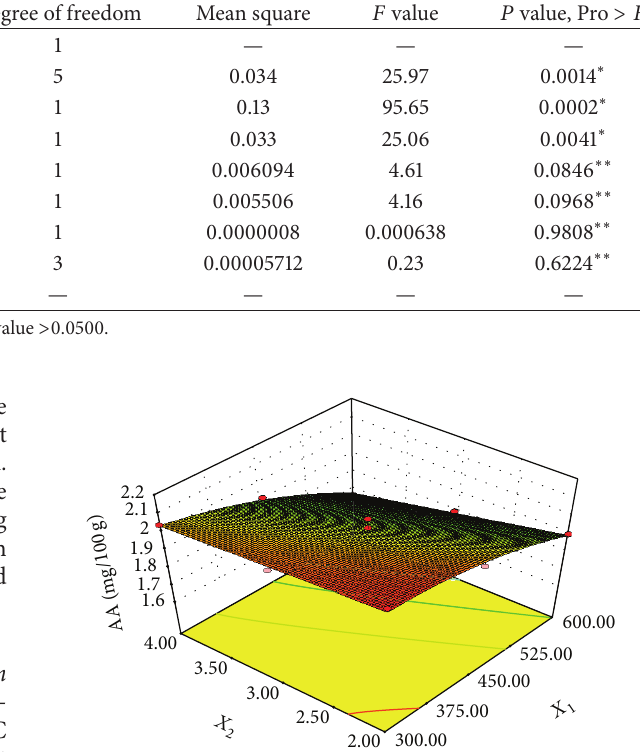
Table 7: Analysis of variance (ANOVA) for the effects of microwave power and microwave time on AA. Source Coefficient estimates